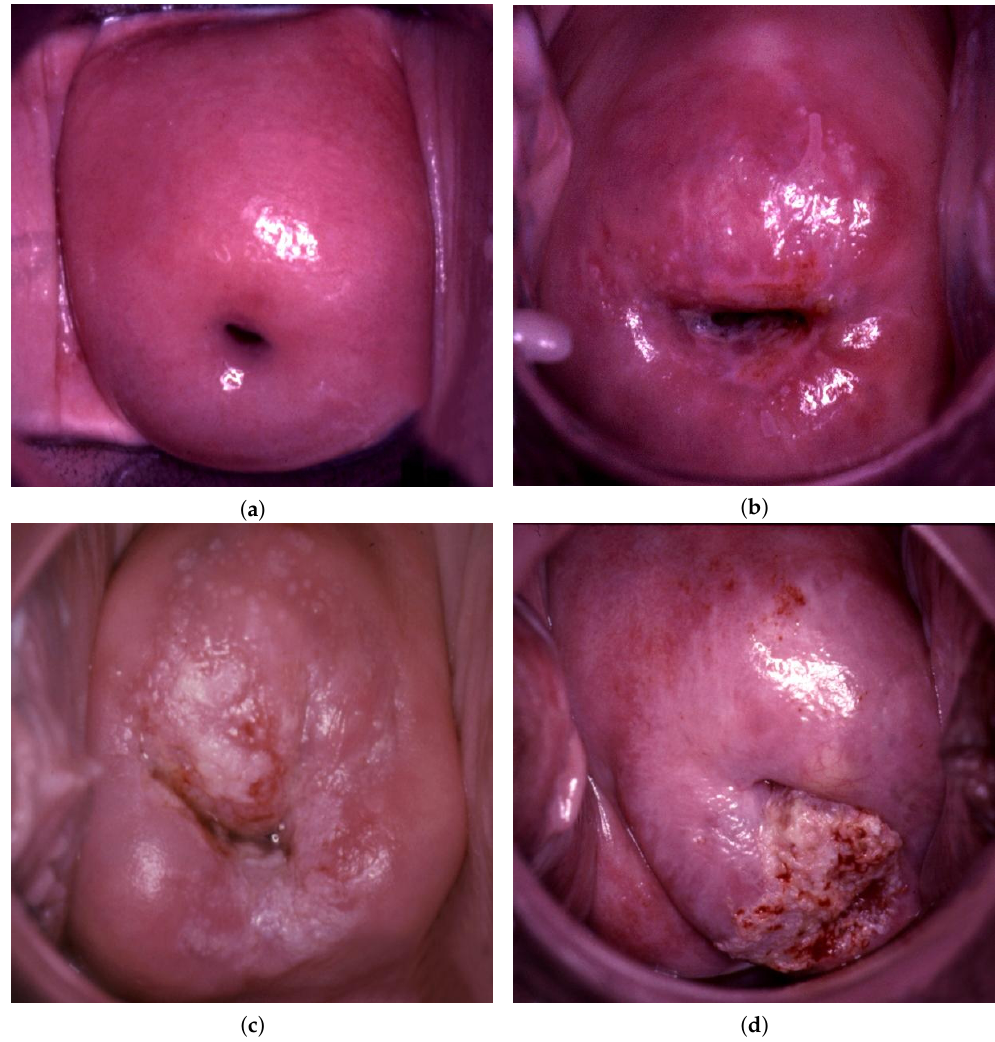
Figure 1. Example colposcopic images of normal cervices and various degrees of abnormal lesions: normal ( a ), LSIL ( b ), HSIL ( c ), and suspicious for invasion ( d